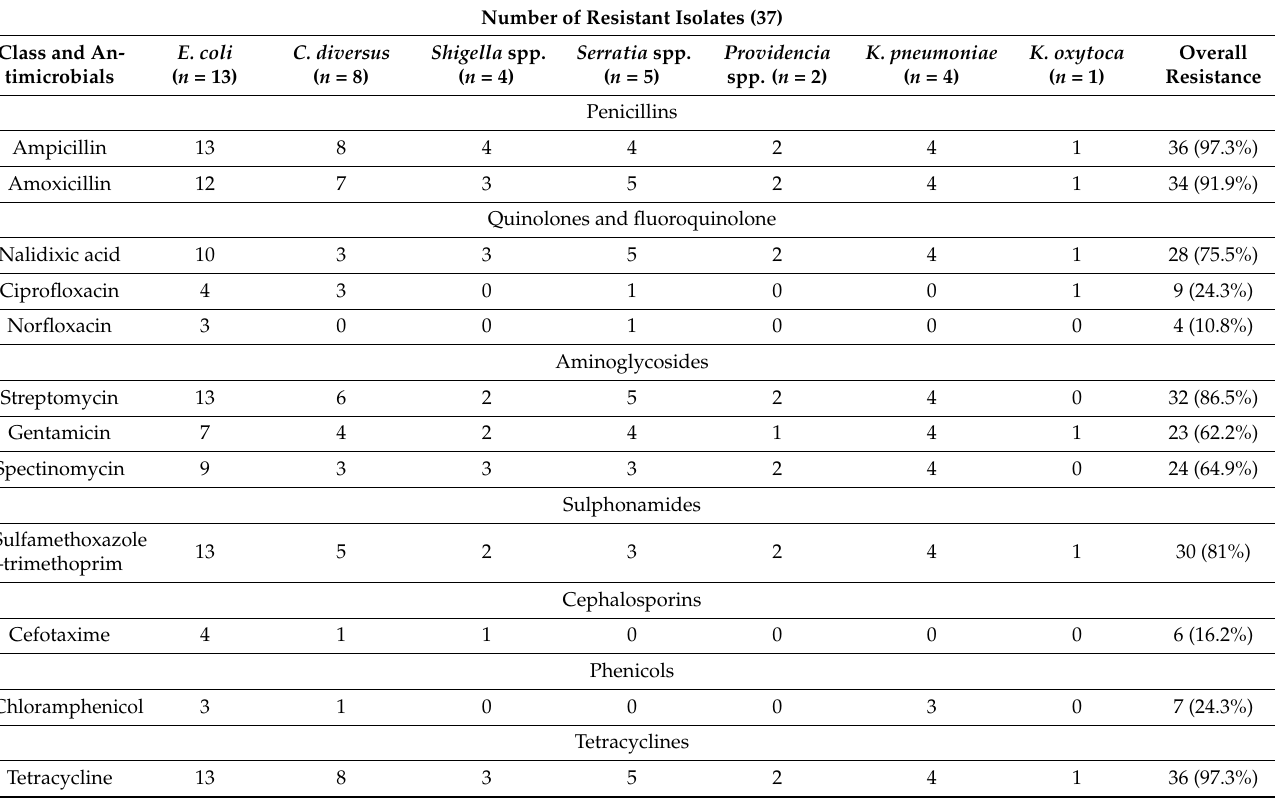
Table 4. Results of antimicrobial susceptibility testing for multidrug resistance of Enterobacteriaceae that were isolated from diarrhoeic